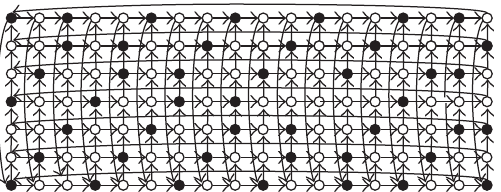
Figure 1: A dominating set of 𝐶 7 ◻𝐶 18 .